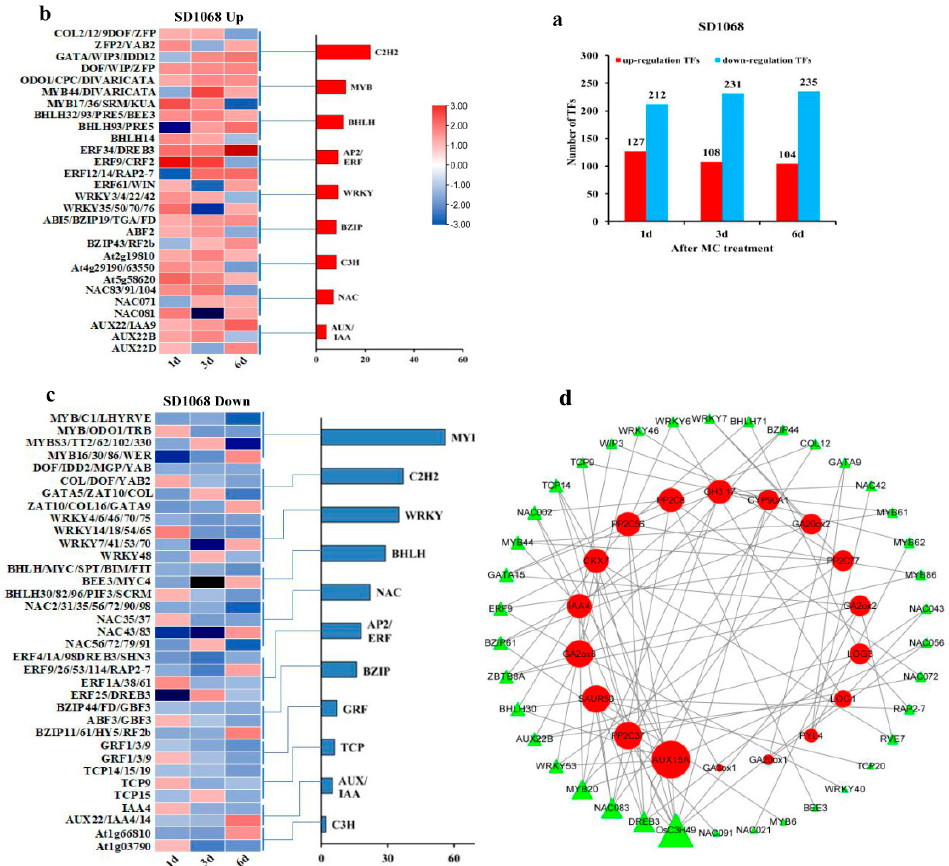
Figure 9. The number and expression patterns of the up- or downregulated transcription factors (TFs) in SD1068. ( a ) The total number of up- or downregulated TFs in SD1068 at three time points after MC treatment. ( b ) The expression pattern of upregulated TFs in SD1068. ( c ) The expression pattern of representative downregulated TFs in SD1068. ( d ) The co-expression network of hormone-related genes and TFs in SD1068. The larger triangles on TFs and circles on hormone-related genes indicated the stronger connectivity, which meant that the corresponding genes were more important for the interaction of TFs with hormone metabolism and signaling